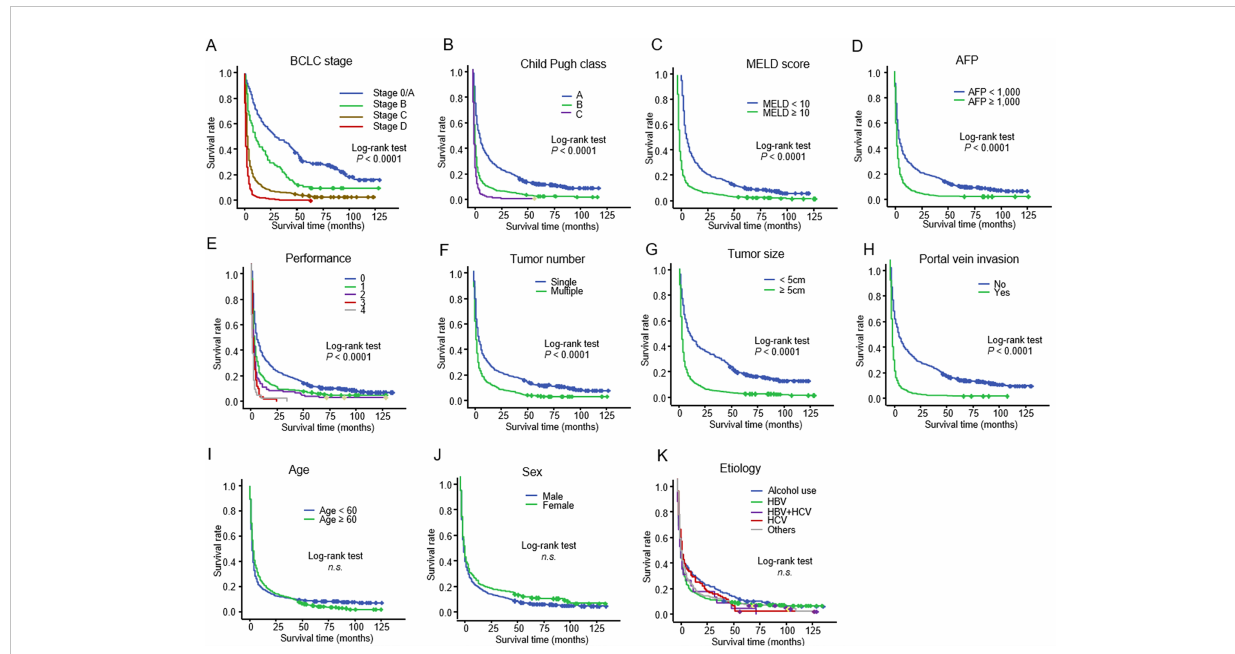
FIGURE 2 Kaplan – Meier curve showing the overall survival in 1,045 patients with untreated HCC strati fi ed according to (A) BCLC stage: (B) Child – Pugh class: (C) MELD score: (D) serum AFP level: (E) ECOG performance score: (F) tumor number: (G) tumor size: (H) portal vein invasion: (I) age (J) sex: and (K) etiology HCC, hepatocellular carcinoma; BCLC, Barcelona Clinic Liver Cancer; MELD, model for end-stage liver disease; AFP, alpha-fetoprotein; ECOG, Eastern Cooperative Oncology